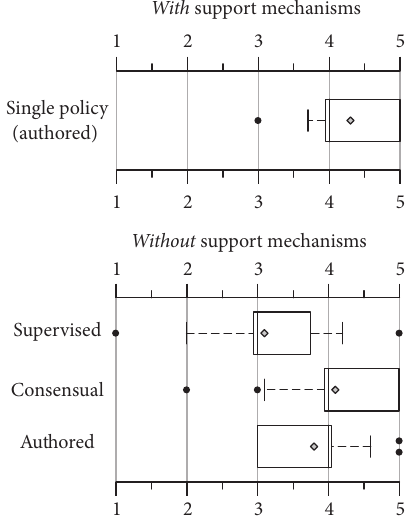
Figure 7: Comparison between questionnaire answers on experi- ence assessment with (II) and without support mechanisms (I).